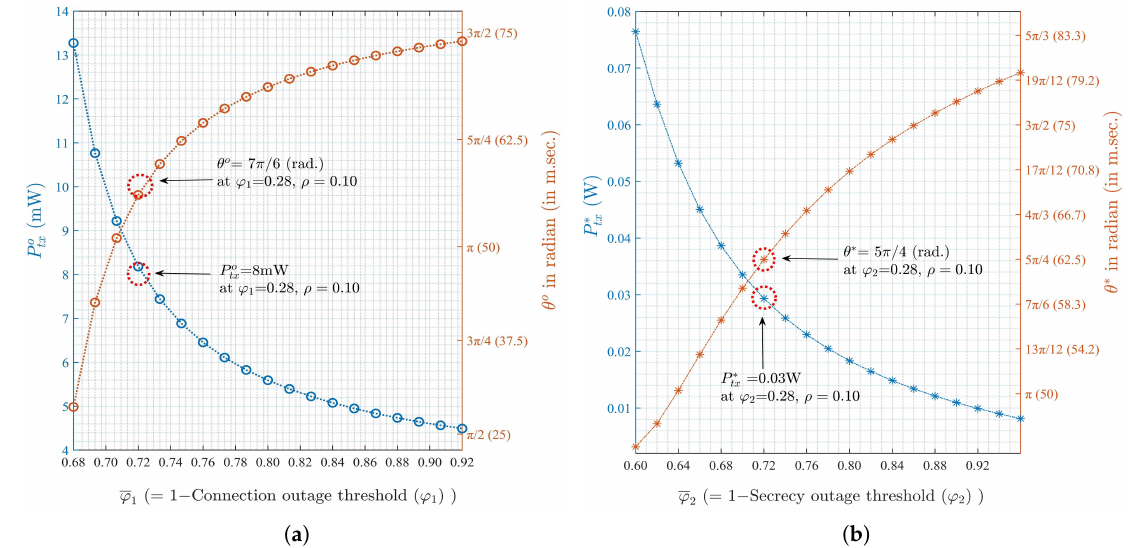
Figure 7. Optimal lengths of sensing phase (duration) and optimal transmit powers for EH-UAV over ( a ) connection outage threshold ( ϕ 1 ), ( b ) secrecy outage threshold ( ϕ 2